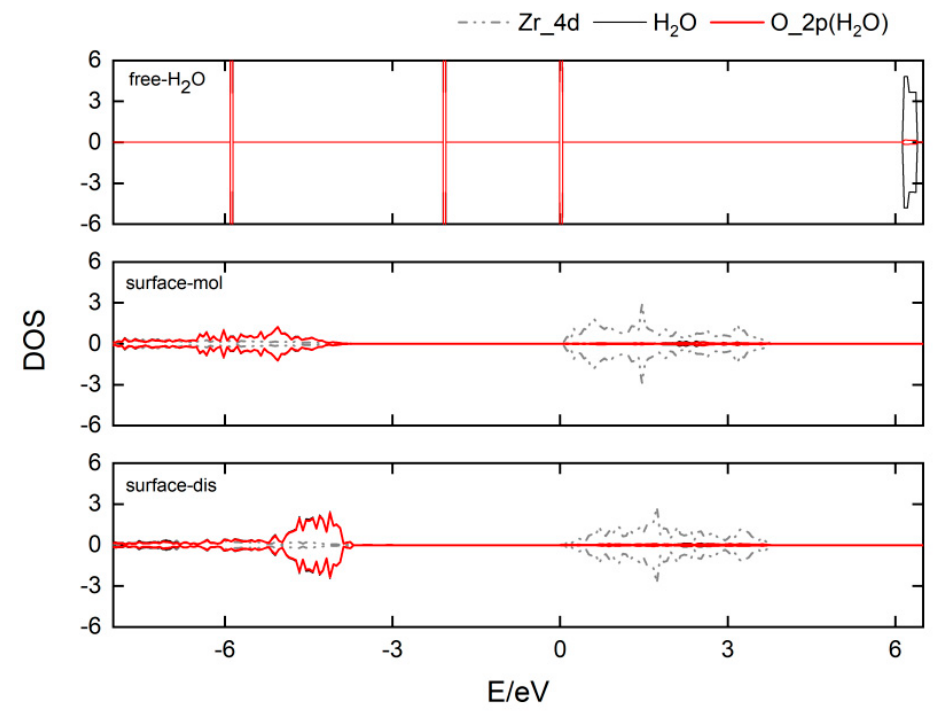
Figure 4. Density of states (DOS) of H 2 O adsorbed on ZrO 2 (111) surfaces and the corresponding dissociative state.